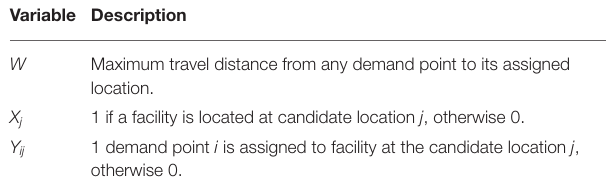
TABLE 2 | List of decision variables for